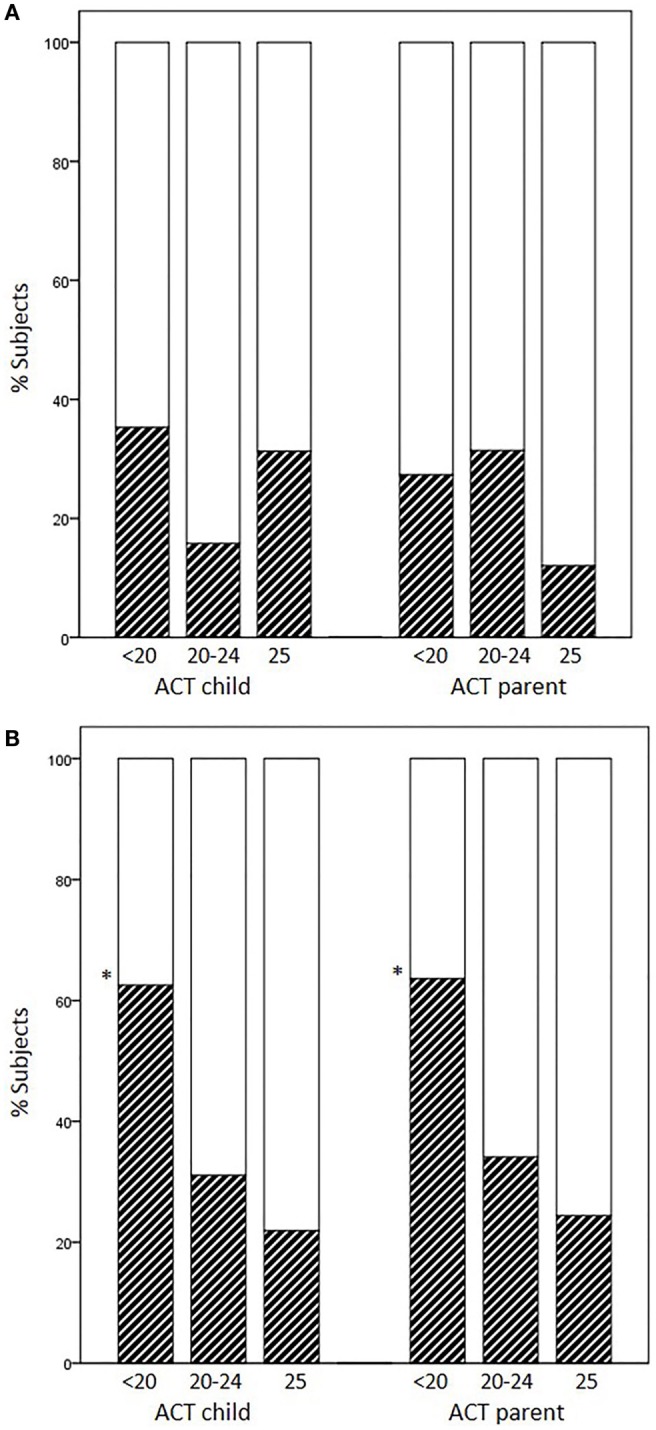
Percentages of EIB cases according to disease-control level: fully controlled (25), partially controlled (20–24), and uncontrolled (<20). (A) Patients aged <12 years, (B) patients aged ≥12 years (*p = 0.017 and p = 0.049 for child and parent ACT, respectively).